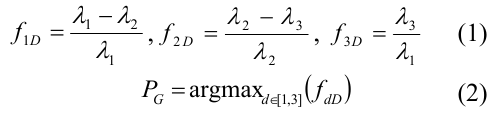
Table 1. Examples of attached